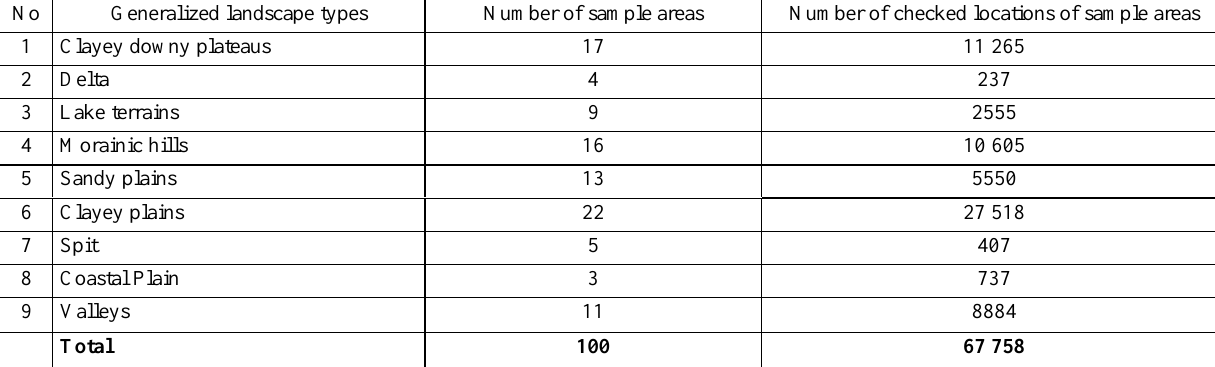
Table 2. Number of sample area locations checked for the structure of land cover in different landscape types No Generalized landscape types Number of sample areas Number of checked locations of sample areas Clayey downy plateaus